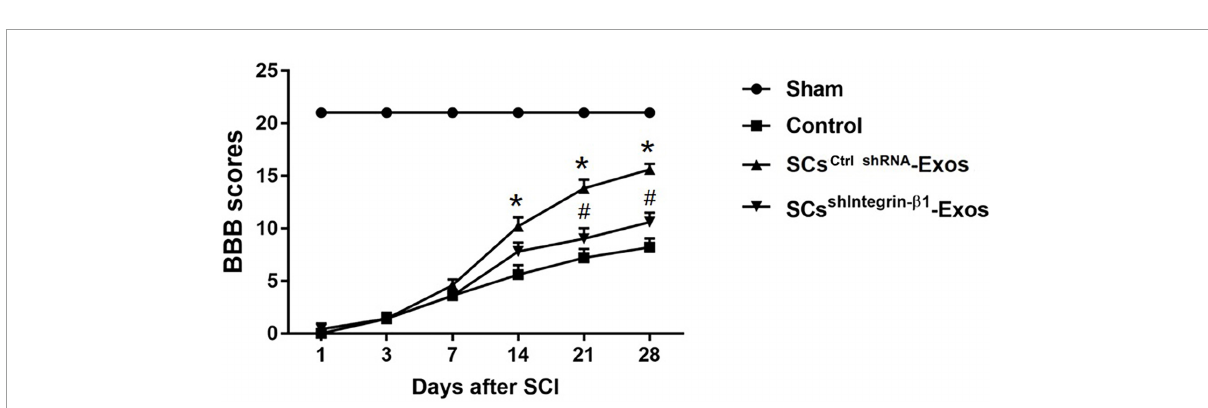
FIGURE8 Exosomal Integrin- β 1 of SCs-Exos improves neurological functional recovery after SCI. Functional recovery after SCI in rats was accessed by BBB scores, which ranged from Day 1 to Day 28 post-SCI. The data are presented as mean ± SD. * p < 0.05 Control group vs. SCs ctrlshRNA -Exos group, # p < 0.05 SCs ctrlshRNA -Exos group vs. SCs shIntegrin − β 1 -Exos group. N = 5 in each group. Scale bar = 1